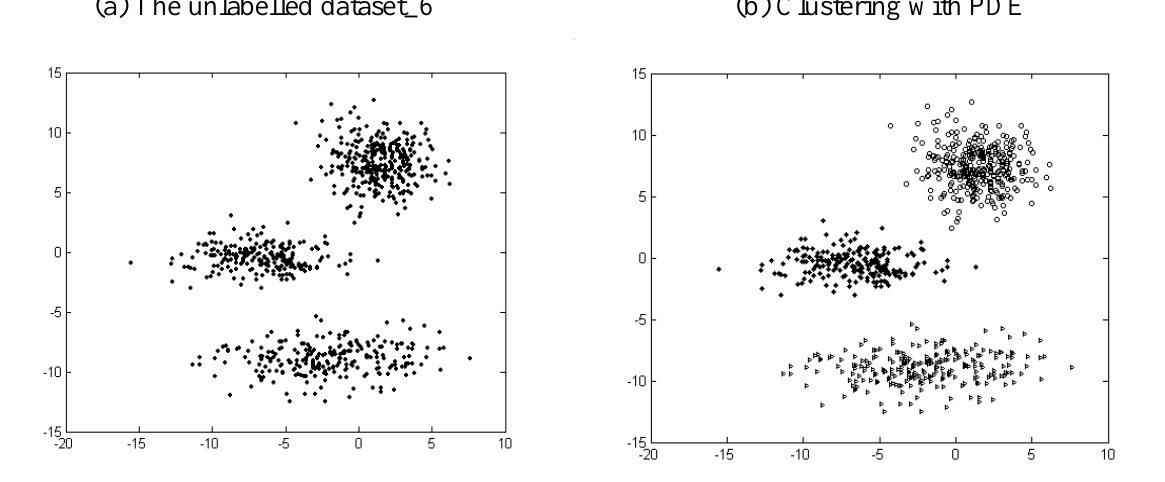
Figure 9. Clustering result for artificial dataset_6.